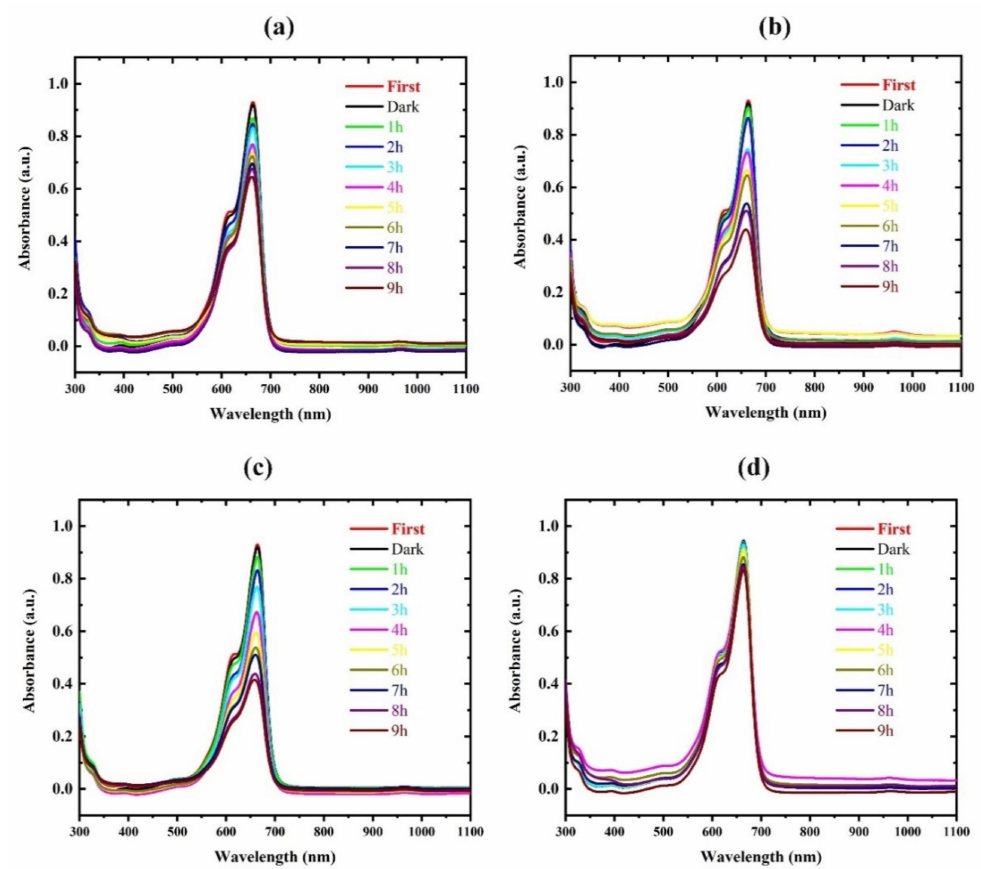
Figure 8. Time-dependent absorption spectra of MB solution during light irradiation in the presence of: ( a ) pristine CuO, ( b ) CuO-2.5G, ( c ) CuO-5G, and ( d ) CuO-10G.